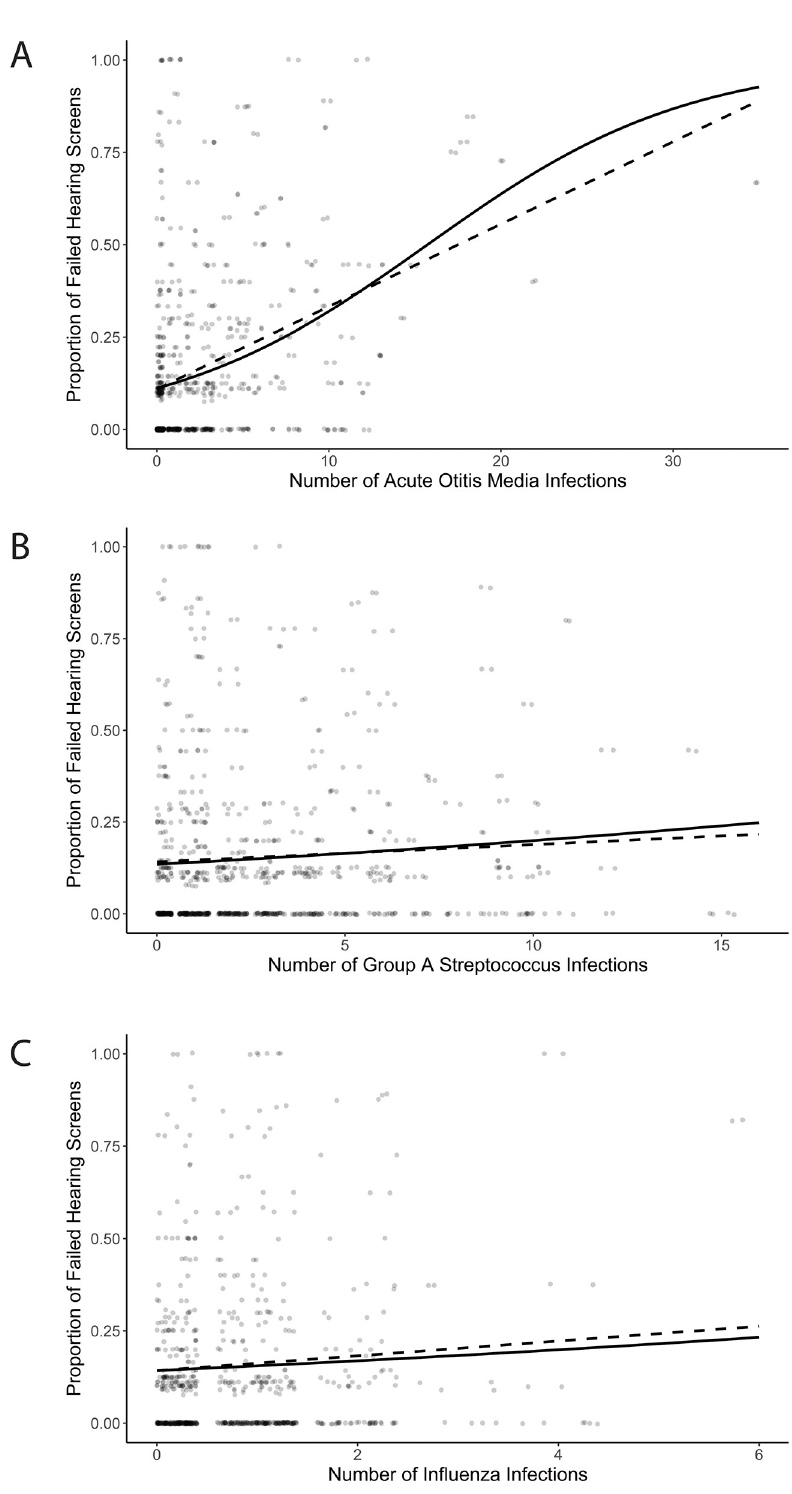
Fig 1. Association between URTI and number of failed hearing screenings. Fig 1A: Number of AOM infections and proportion of failed hearing screenings later in life. Fig 1B: Number of GAS infections and proportion of failed hearing screenings. Fig 1C: Number of Influenza infections and proportion of failed hearing screenings. Proportion of failed hearing screens was calculated as follows: number of failed hearing screens/total hearing screens. Solid line: binomial logistic regression. Dotted line: linear